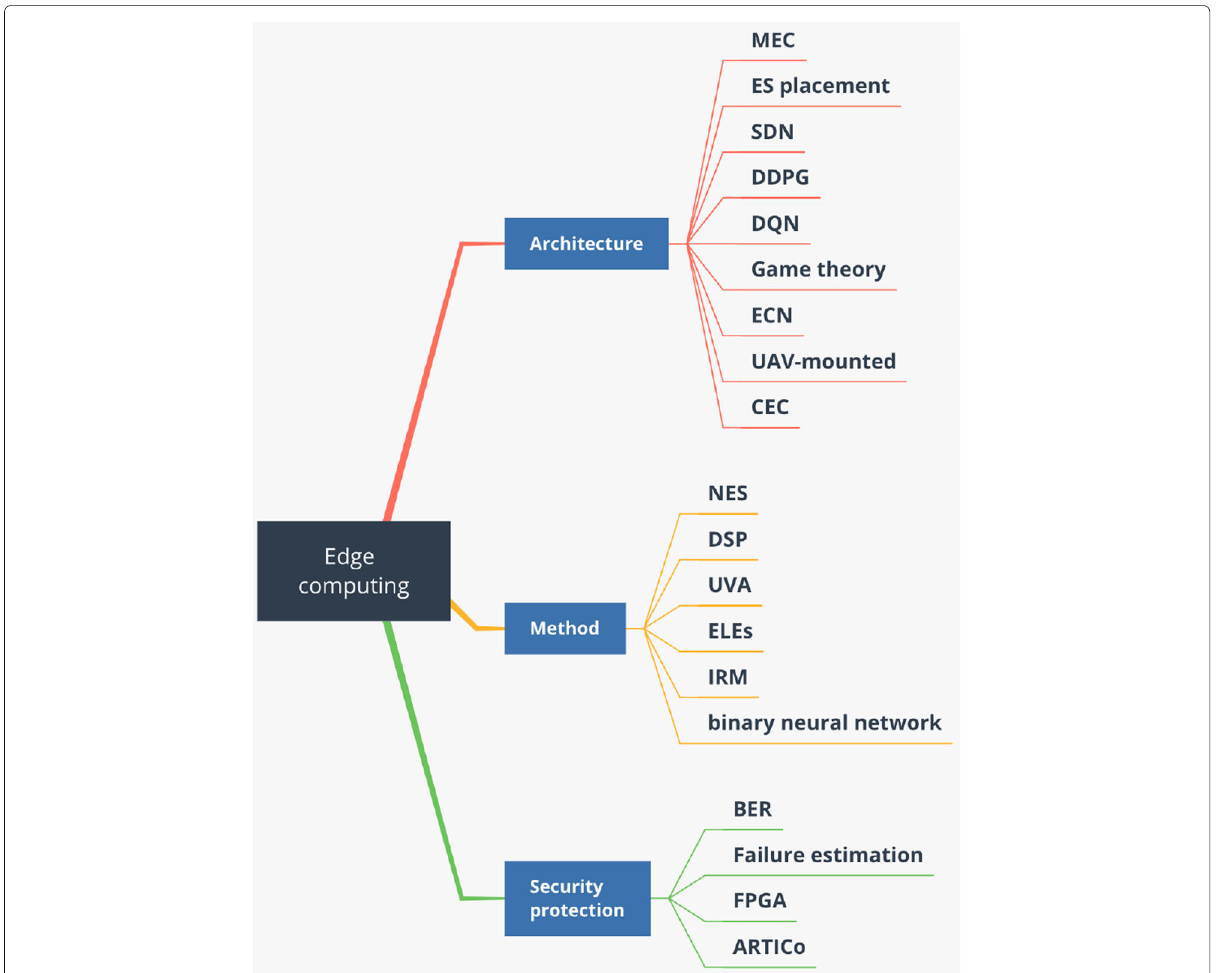
Fig. 5 A conclusion of methods adopted for CPS in edge